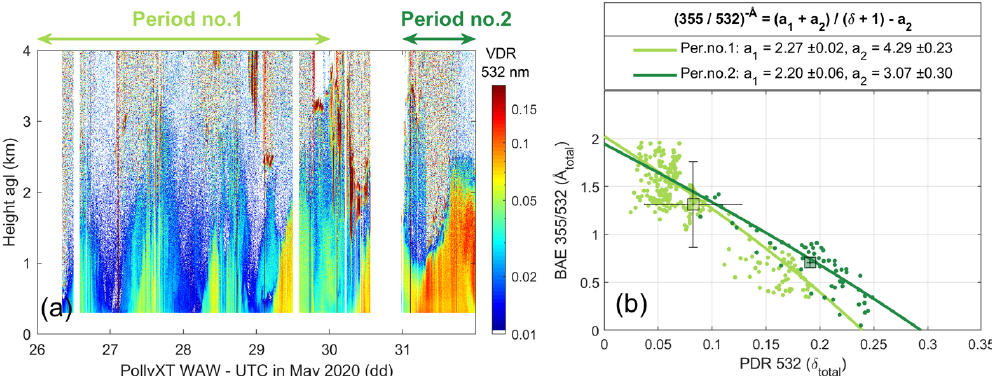
Figure 4. (a) Time–height cross section of volume depolarization ratio (VDR) at 532nm from Polly XT at Warsaw station on 26–31 May 2020. The two selected periods are indicated on the top. (b) Similar to Fig. 2 but for two periods at Warsaw station. Table 4. Comparison of characteristic values of background and pollen/dust particles, for selected periods of Warsaw and Hohenpeißenberg stations. δ : depolarization ratio at 532nm. Å : backscatter-related Ångström exponent between 355 and 532nm. The index d is used for the depolarizing particles (i.e. pollen or dust). Station Selected period Profile (bin) Background Possible depolarizing δ d in May 2020 (dd) number δ bg Å bg particle